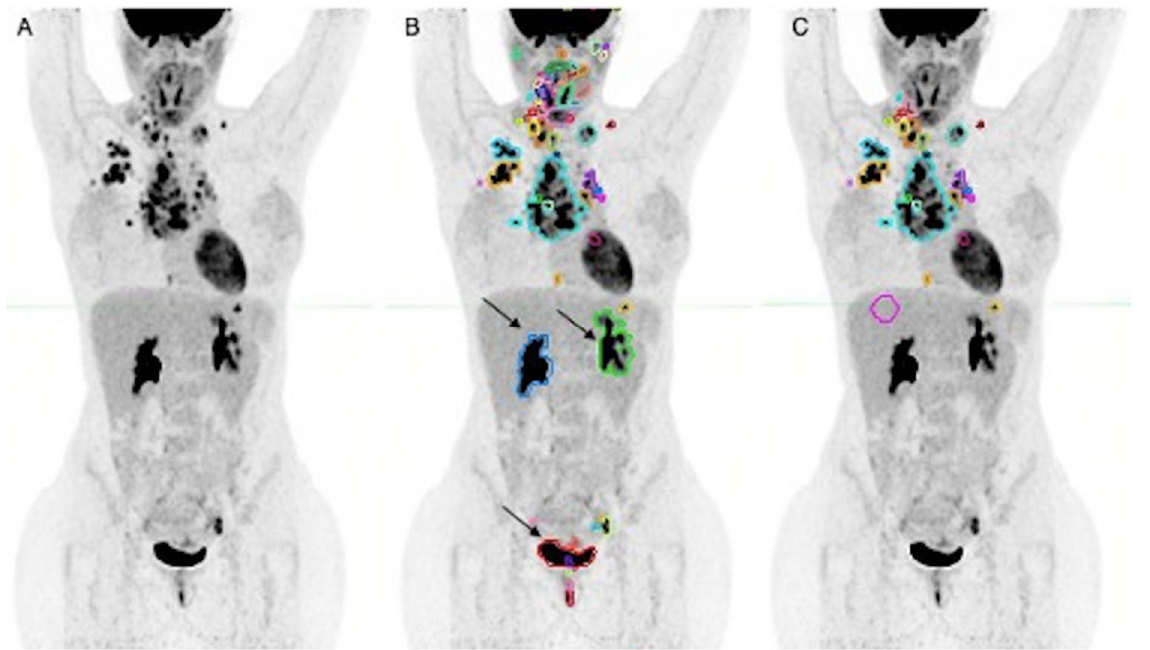
Figure 1. Total metabolic tumor volume (TMTV) calculation. Maximum intensity projection (MIP) views of a 32-year-old female patient with stage IVA nodular sclerosing Hodgkin lymphoma. ( A ) Unprocessed MIP. ( B ) Semiautomatic segmentation of the whole-body using LesionID ® tool from MIM Encore Software (version 7.0.5, MIM Encore Software Inc., Cleveland, OH, USA); some contoured physiological sites of uptake (e.g., black arrows) were later excluded from the analysis. ( C ) Revised contouring by two nuclear medicine physicians in consensus, which was then processed by the software to obtain the TMTV volumetric parameter (105.05 mL). The pink circle in ( C ) is the region of interest on the right liver lobe for PERCIST-based cut-off criterion for volumes of interest determination (see text for more detail).